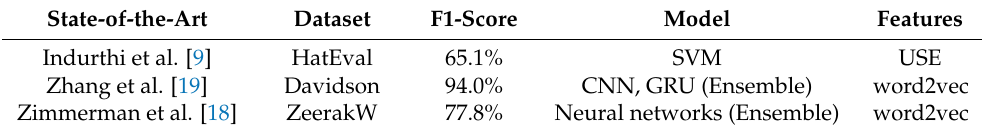
Table 12. Summary of the state-of-the-art approaches on used